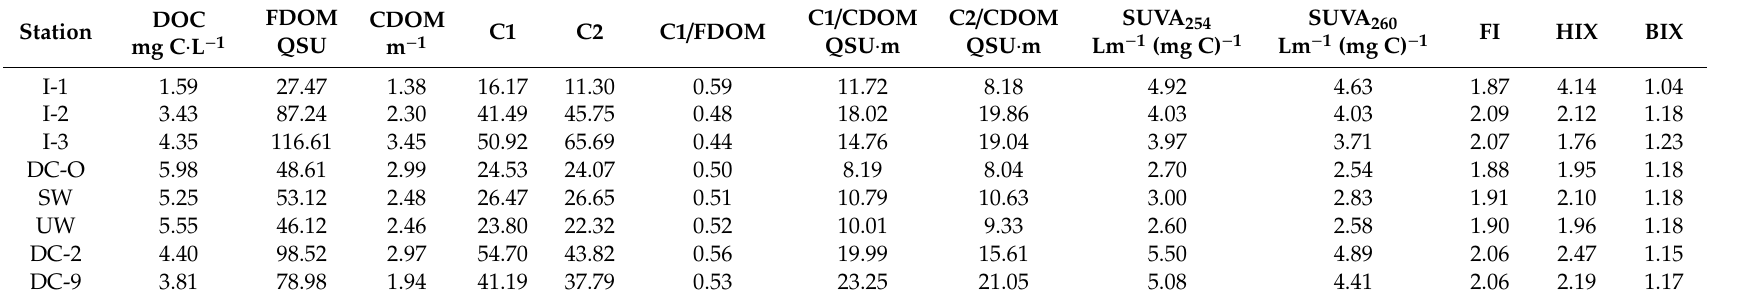
Table 1. Spectral and fluorescent properties of dissolved organic matter (DOM) in surface, underlying, and pore water.